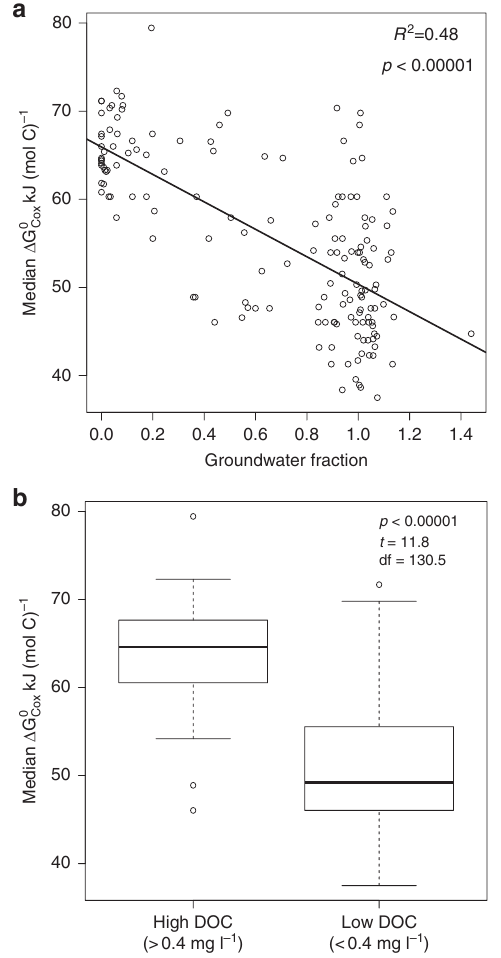
Fig. 4 Patterns of within sample median Gibbs free energy of the organic carbon oxidation half reaction ( Δ G 0 ). a Median Δ G 0 derived from Cox Cox FTICR – MS shows a signi fi cant negative relationship with the groundwater (GW) fraction, determined using Cl − as a conservative tracer; thermodynamic favorability decreases with increases in Δ G 0 . Regression Cox statistics are provided. b Boxplots summarizing the distributions of median Δ G 0 , which show a signi fi cant shift across a DOC concentration threshold Cox of 0.4 mg l − 1 ; t -test statistics are provided. These two results indicate accumulation of thermodynamically favorable DOC in GW despite (Fig. 3a), thereby contradicting the classic paradigm of decreasing